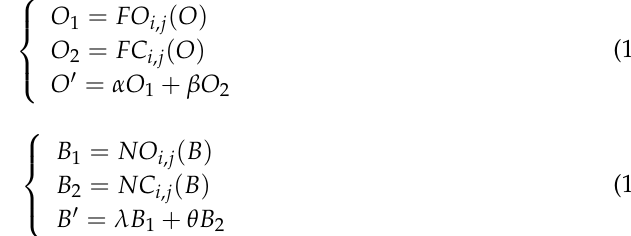
After the threshold segmentation and de-noising process, the objects in the foreground region remain stuck to each other and need to be further segmented. Each object has two boundaries: one is the boundary between the foreground object and the background area, and the other is the boundary between the objects that are stuck together. These are all located in the foreground area where the threshold was segmented, and the segmentation results can be achieved by determining these boundaries. In the foreground region where the threshold is segmented, the gray value of the boundary region adjacent to the background region is greater than the gray value of the region surrounding it [29]. Therefore, the boundaries of all the objects to be segmented in the pretreated graph have locally higher gray values. The dome can be defined as a region with a larger gray value in the local region, and the above boundary region is considered as a dome [30], so it can be extracted by grayscale morphological reconstruction. To avoid missing boundary points, different domes are extracted in different directions. In this work, we select six directions in equal intervals from 0° to 180°. 3.5. Wheat Ear Detection and Statistics After the above operation, we get several separate and disconnected bright areas, each of which represents an unidentified wheat ear. Here, we use the regionprops function in Matlab R2017b to count the independent regions in the image so as to count the number of wheat ears. Meanwhile, we processed Ground Truth operation for each image, and manually labeled the wheat ears in the image, so as to compare with the result of computer recognition. 4. Results 4.1. Multispectral and Panchromatic Image Fusion Results Based on the Gram–Schmidt Algorithm After pre-processing with ortho-photo correction and image registration, the two types of images are fused by using the GS transform. Figure 5 shows the original panchromatic images and the corresponding fusion results, respectively (Figure 5).